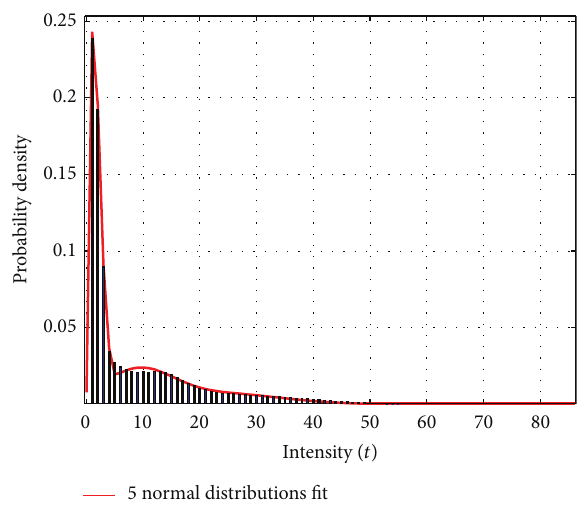
Figure 9: Five normal distributions fitted. Table 2: Probability distribution parameters for the vehicle loads. Two-axle Three-axle Four-axle Five-axle